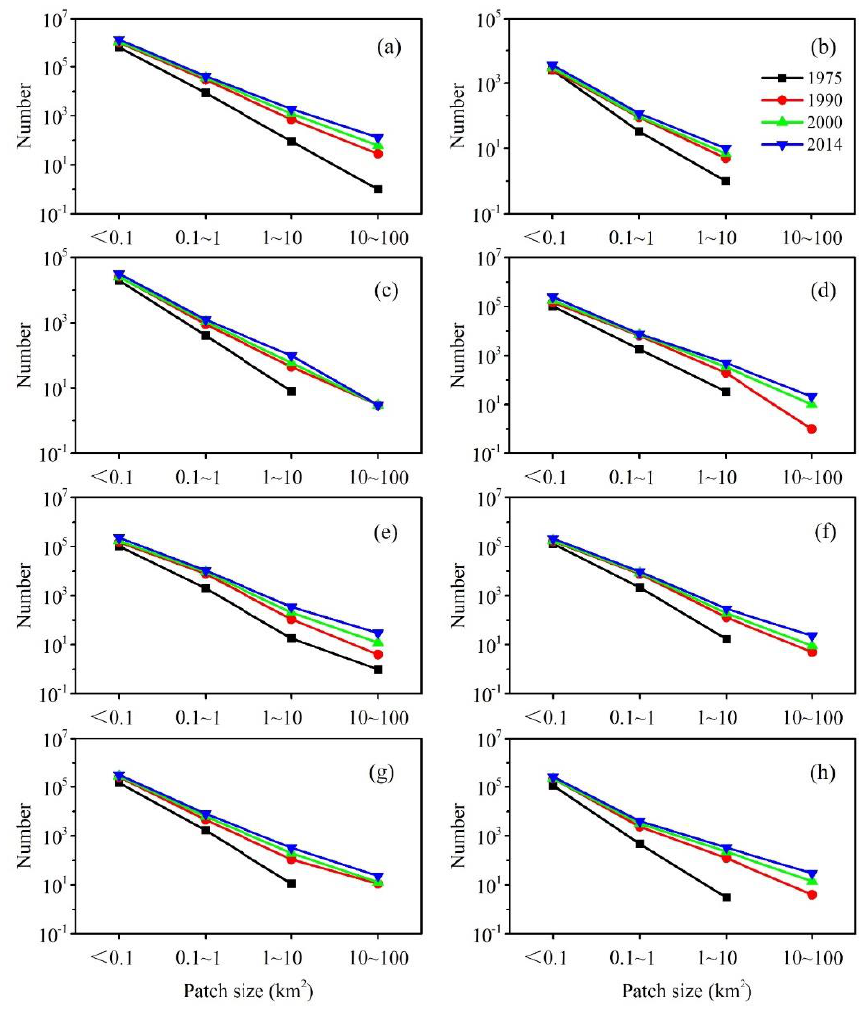
Figure 10. The number distribution of different growth patch sizes in the North China Plain Area: ( a ) North China Plain Area; ( b ) Beijing; ( c ) Tianjin; ( d ) Hebei; ( e ) Shandong; ( f ) Henan; ( g ) Anhui; and ( h ) Jiangsu.